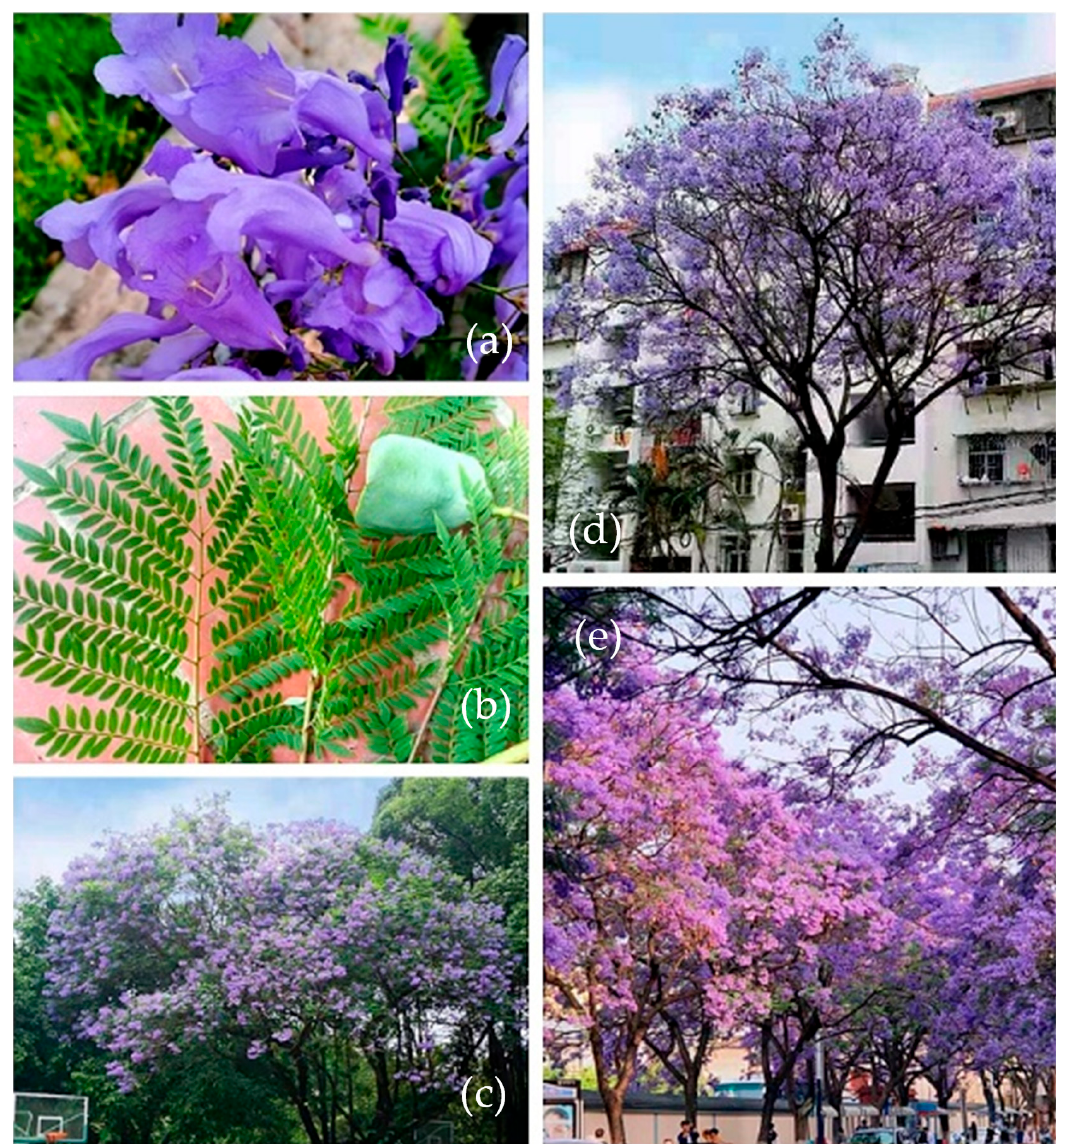
Figure 1. Landscape and botanical features of Jacaranda mimosifolia in China. Its ornamental and botanical features are displayed: ( a ) flowers; ( b ) bipinnate compound leaves and fruit; ( c – e ) trees in bloom and tree form in Yibin (Sichuan), Xiamen (Fujian) and Kunming (Yunnan), respectively.